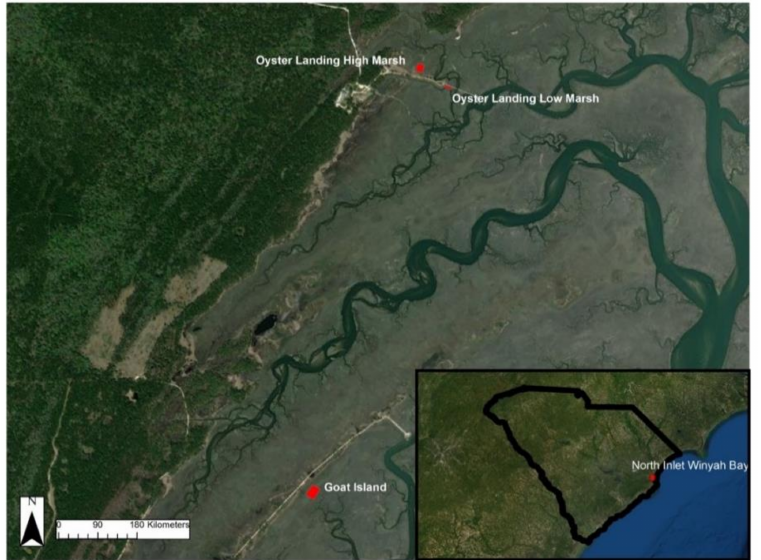
Figure 1. NIWB study site locations. South Carolina is located in the southeastern USA, bordering Georgia, North Carolina, and the Atlantic